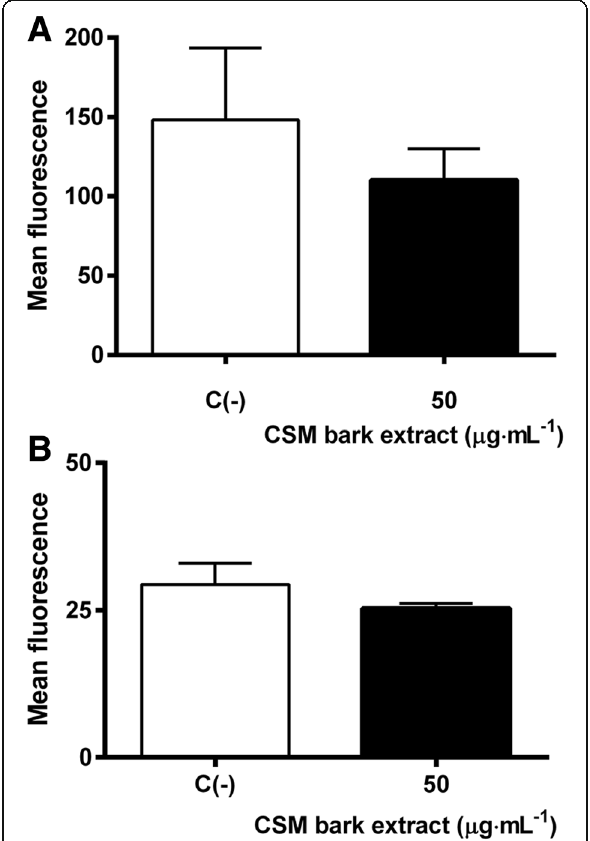
Fig. 6 p53 ( a ) and Bax ( b ) mean fluorescence intensity after 72 h treatment with 50 μ g·mL − 1 CSM bark extract at the indicated concentration. p53 and Bax levels were evaluated by FCM as described in Methods. Each bar represents the mean ± SEM of five independent experiments. Data were analyzed by t-test for paired